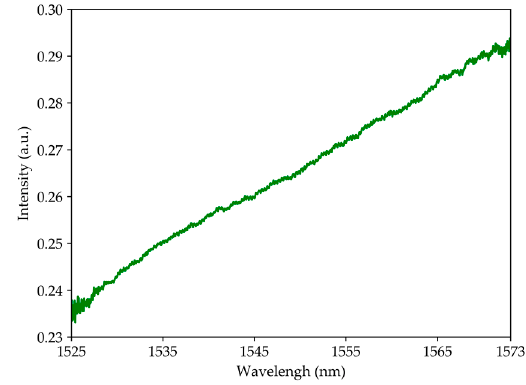
Figure 5. Output signal spectrum when geometry is suspended in air.